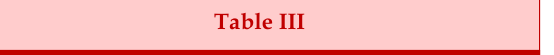
Adverse drug reactions in course of treatment